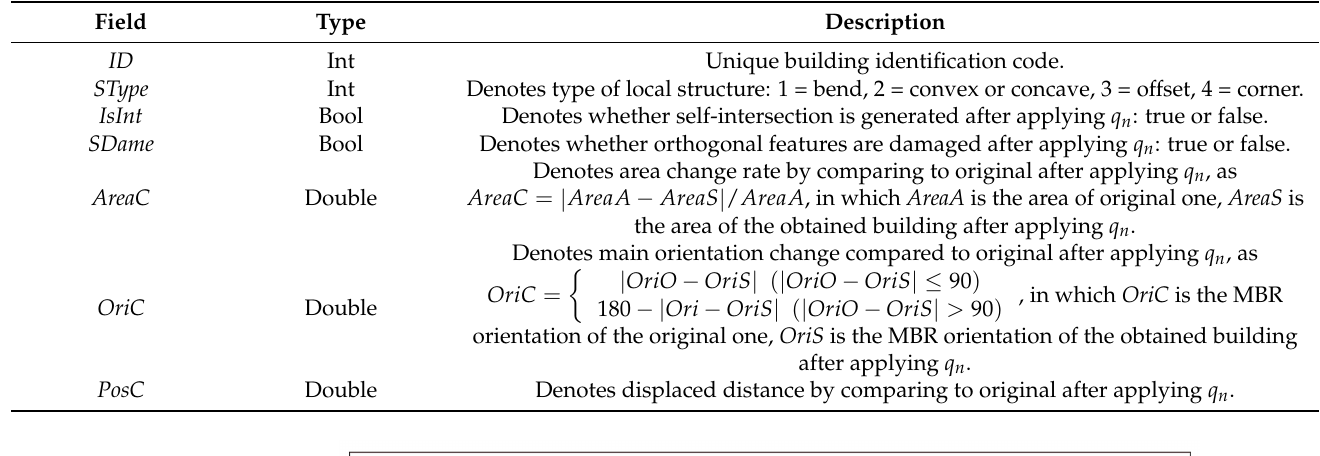
Table 2. Data structure to record changes in building characteristics after applying q n .